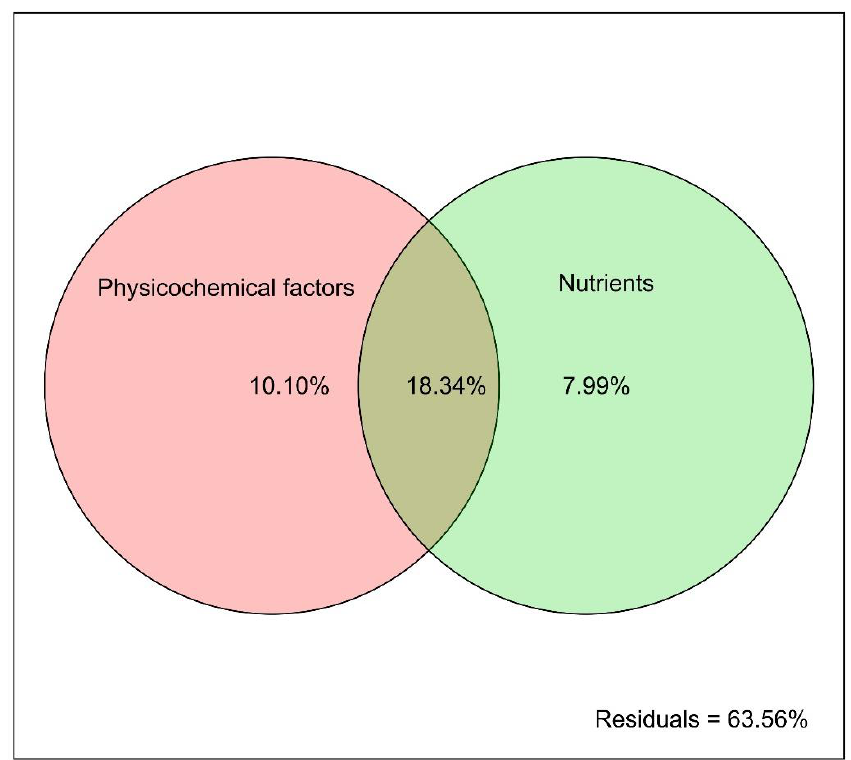
Figure 4. Venn diagram showing the contribution of environmental factors to community variation using variance partitioning analysis (VPA) analysis.